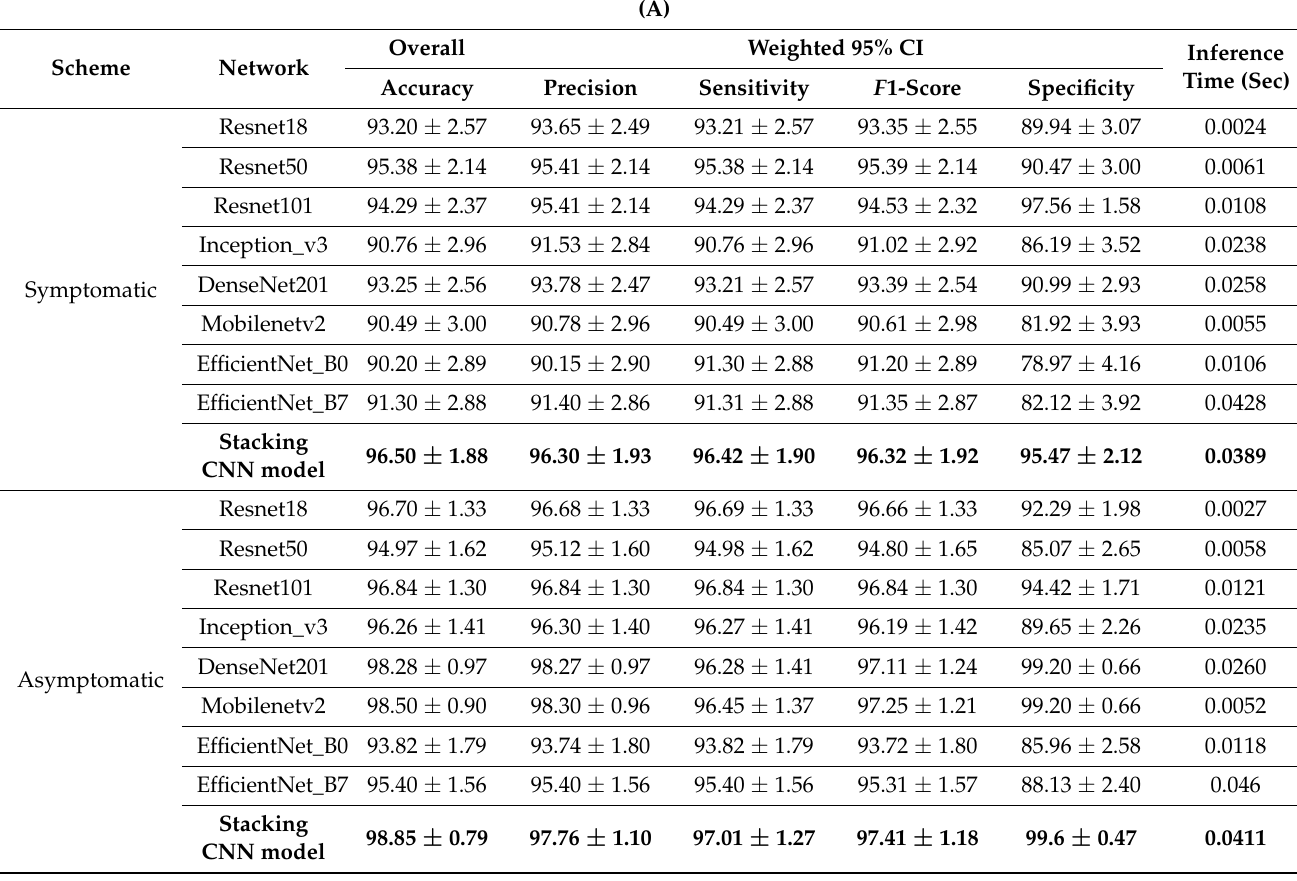
Table 5. Comparison of different CNN performances for binary classification for symptomatic and asymptomatic patients’ (A) cough and (B) breath sounds.